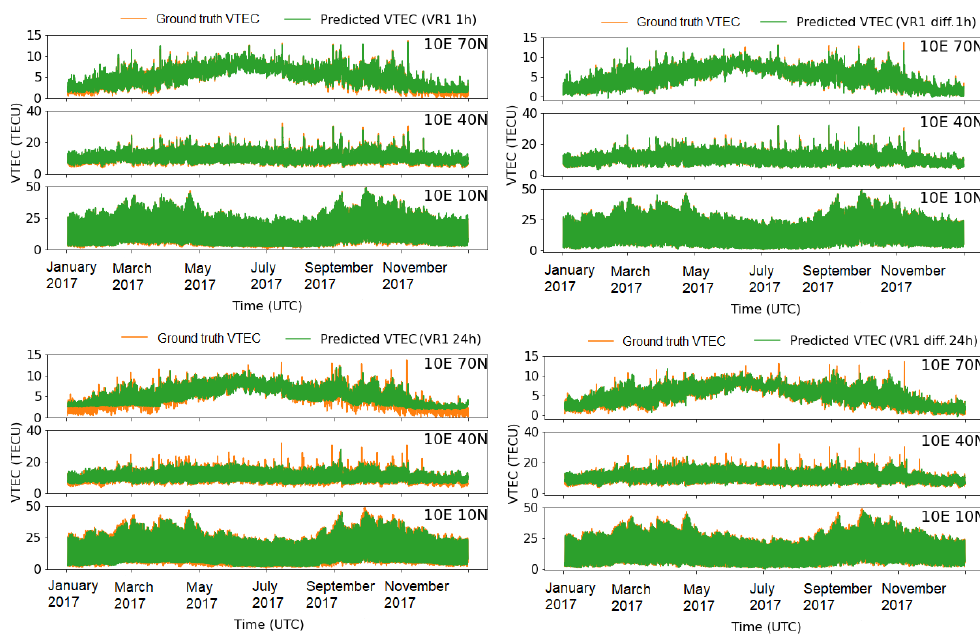
Figure 18. Forecasted VTEC by the VR1 model (green) and ground truth VTEC (orange) during year 2017. Top : 1 h, bottom : 24 h forecast. Left : non-differenced data, right : differenced data.